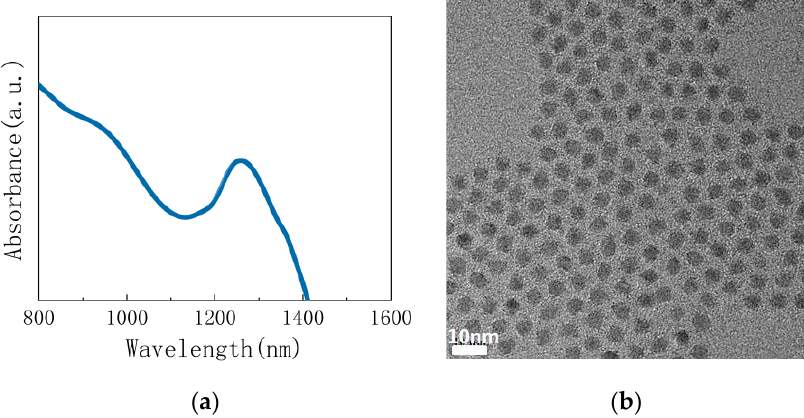
Figure 1. ( a ) Absorption spectrum of PbS QDs; ( b ) TEM image of PbS QDs in the presence of an oleic acid ligand.